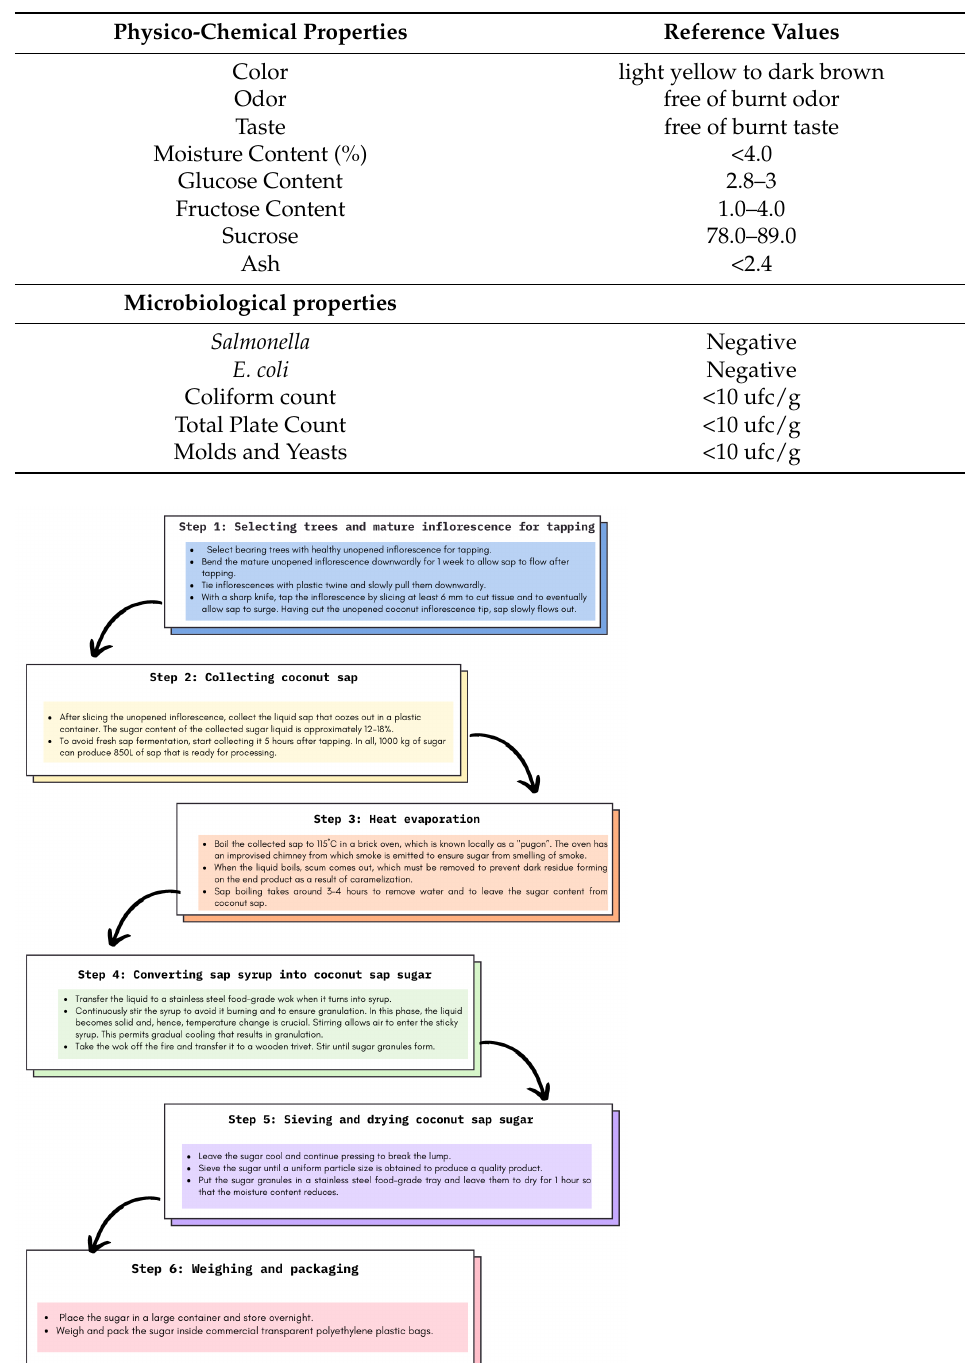
Table 5. Reference values for palm sap sugar products. Adapted from Ref. [74].